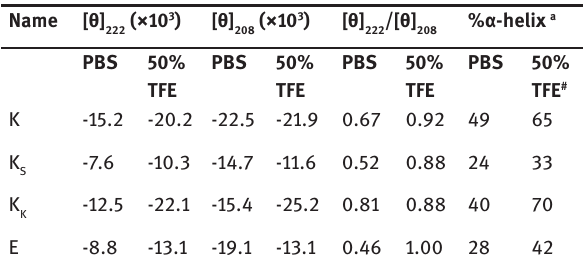
Table 2 : CD spectroscopic data of the acetylated peptides in PBS